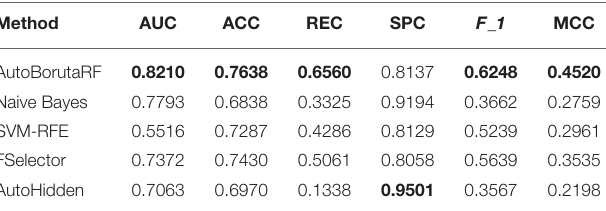
TABLE 3 | Mean values of six evaluation metrics obtained from CCLE.